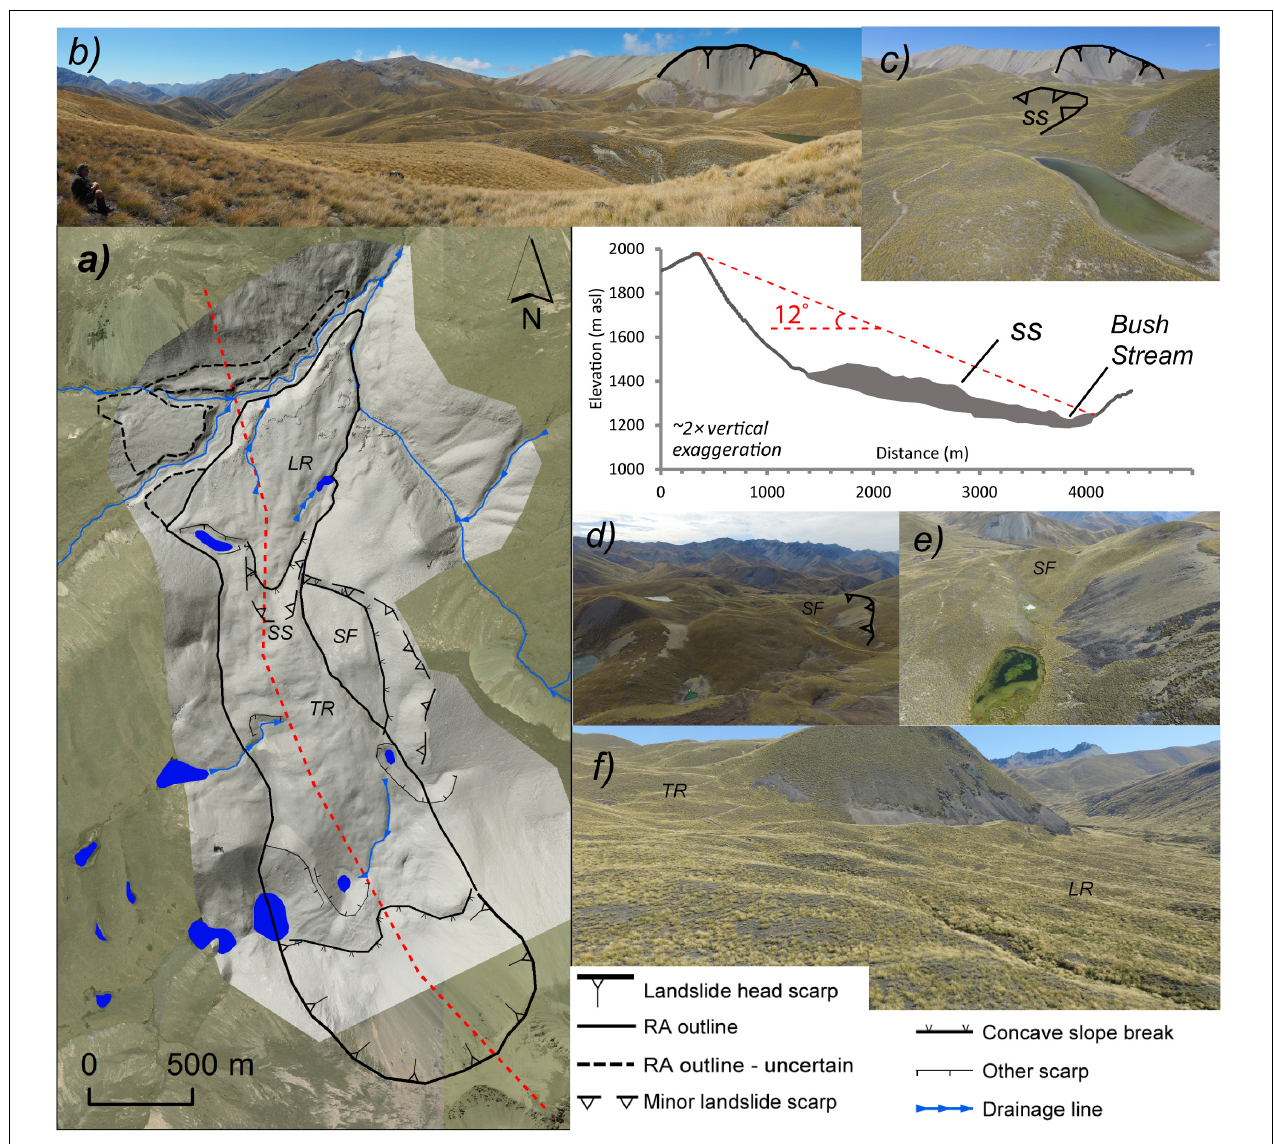
FIGURE 3 | (a) Geomorphological map of the Bush Stream Rock avalanche with corresponding long-section (dashed red line on map) with runout angle and inferred deposit shown in gray shading. Lakes are shown as blue on the map. The base image is the hillshaded 0.5 m SfM DEM on top of LINZ aerial imagery. LR = longitudinal ridges; SS = secondary scarp; SF = other slope failure; TR = transverse ridges. Supporting photos are provided to show some morphological features: (b) Photo taken from slope opposite distal end of deposit looking south toward the head scarp. (c) Photo looking southeast with view of the secondary scarp (SS) within the deposit. (d) Photo looking north-west along the rock avalanche deposit, taken from near the base of the head scarp, with several of the lakes visible, and the other slope failure (SF) abutting Bush Stream Rock Avalanche; (e) View looking north, with closer view of the other slope failure (SF); (f) View looking south-west from near the distal end of the deposit, showing narrow ridges (LR) aligned parallel to flow in the distal part of the deposit and shorter ridges (TR) aligned more transverse to flow in the mid reaches of the